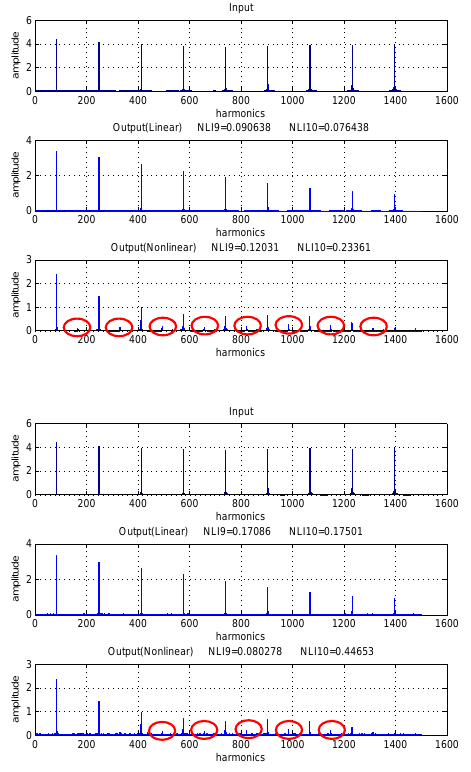
Figure 4: Top. Coherence function of Duffing system in linear and nonlinear modes with a non- periodic excitation signal include measure- ment noise. Bottom. Nonlinearity mea- sures NLI 1 , NLI 2 , NLI 3 for Duffing system with non-periodic excitation signal and mea- surement noise